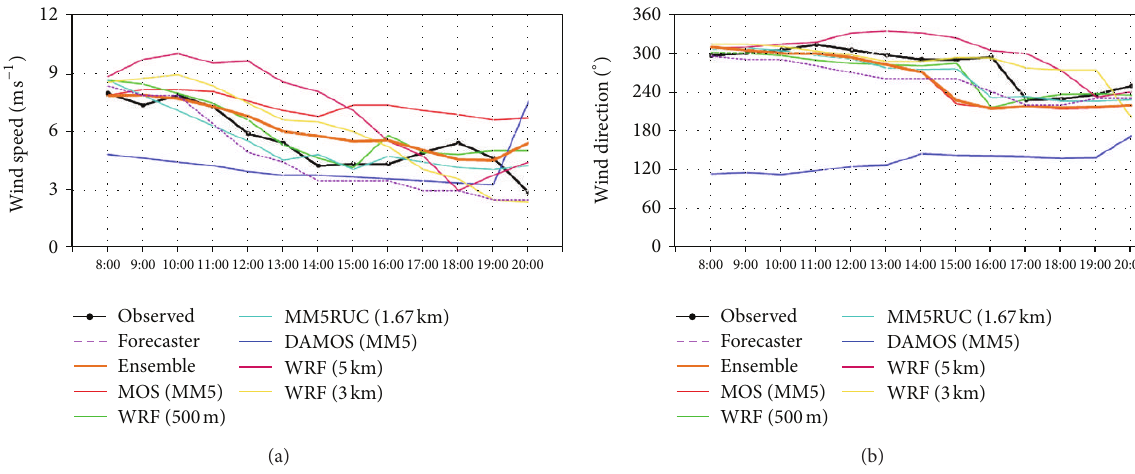
Figure 6: Hourly forecasts of 10m wind speed (a) and wind direction (b) on August 18, 2008 for buoy B.